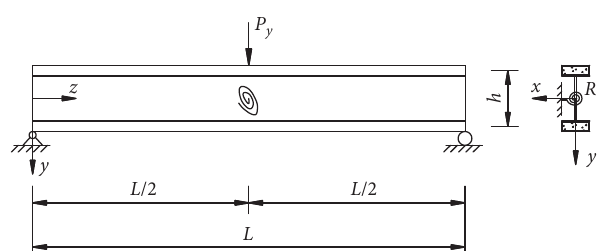
Figure 3: Calculation diagram of simply supported CFTFGS with torsional bracing under point load.